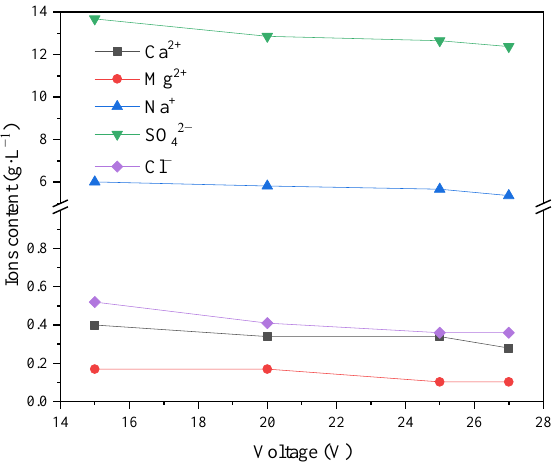
Figure 17. Ion content after desalination under different voltages.